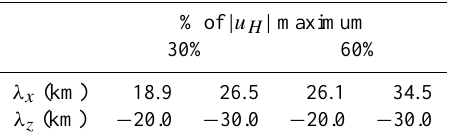
Table 3. Individual GW parameters for verifying u H spectrum.